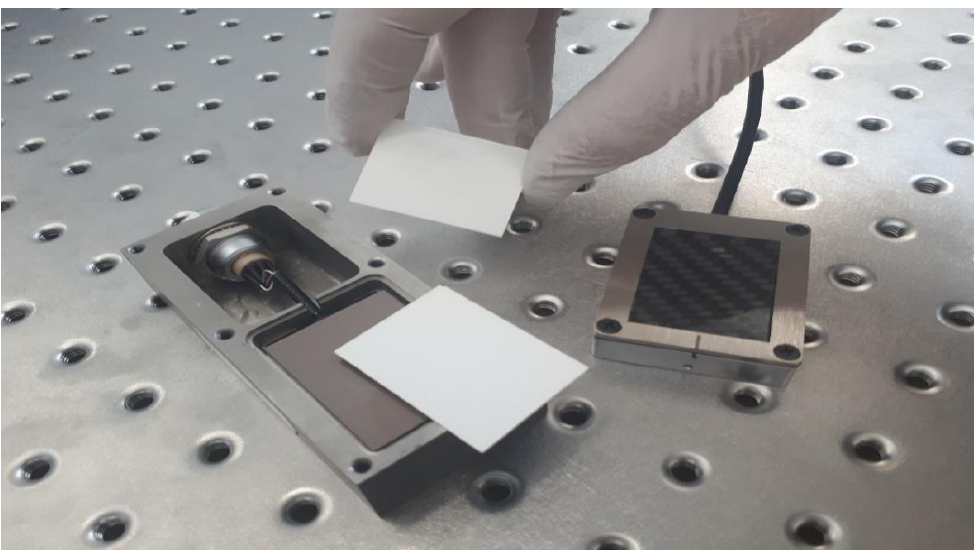
Figure 1. Non-destructive testing CMOS imaging sensors coupled with Gd 2 O 2 S phosphor screens.